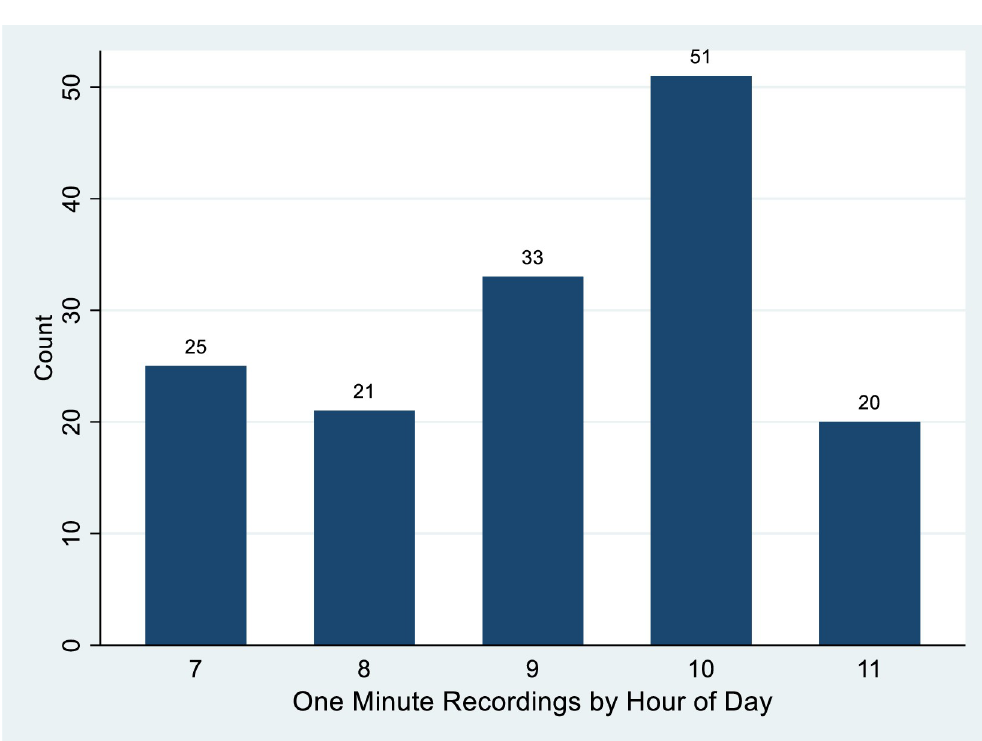
Fig 3. Count of minutes observed by hour at Arches National Park visitor center on 7/12/2020 and 7/14/2020.